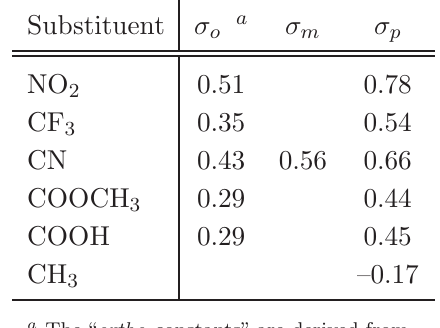
Table 1 Values for Hammett and related substituent constants a